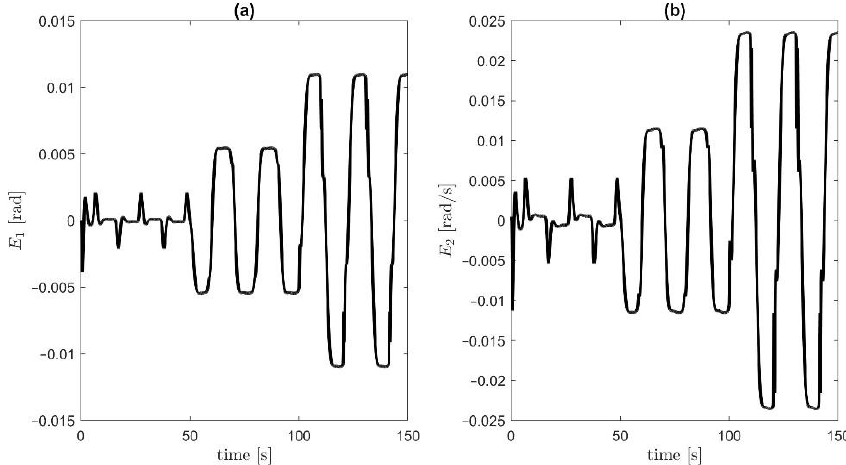
Figure 15. ( a ) Tracking error 𝐸 1 , ( b ) tracking error 𝐸 2 .